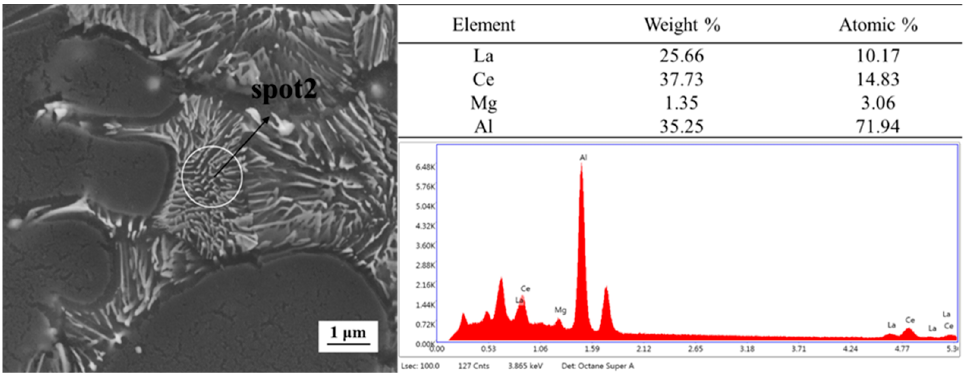
Figure 6. SEM image and the representative point EDS spectrum along with the analysis results of the block phase in the Mg-4Al-4 (La, Ce)-1Sm alloy.